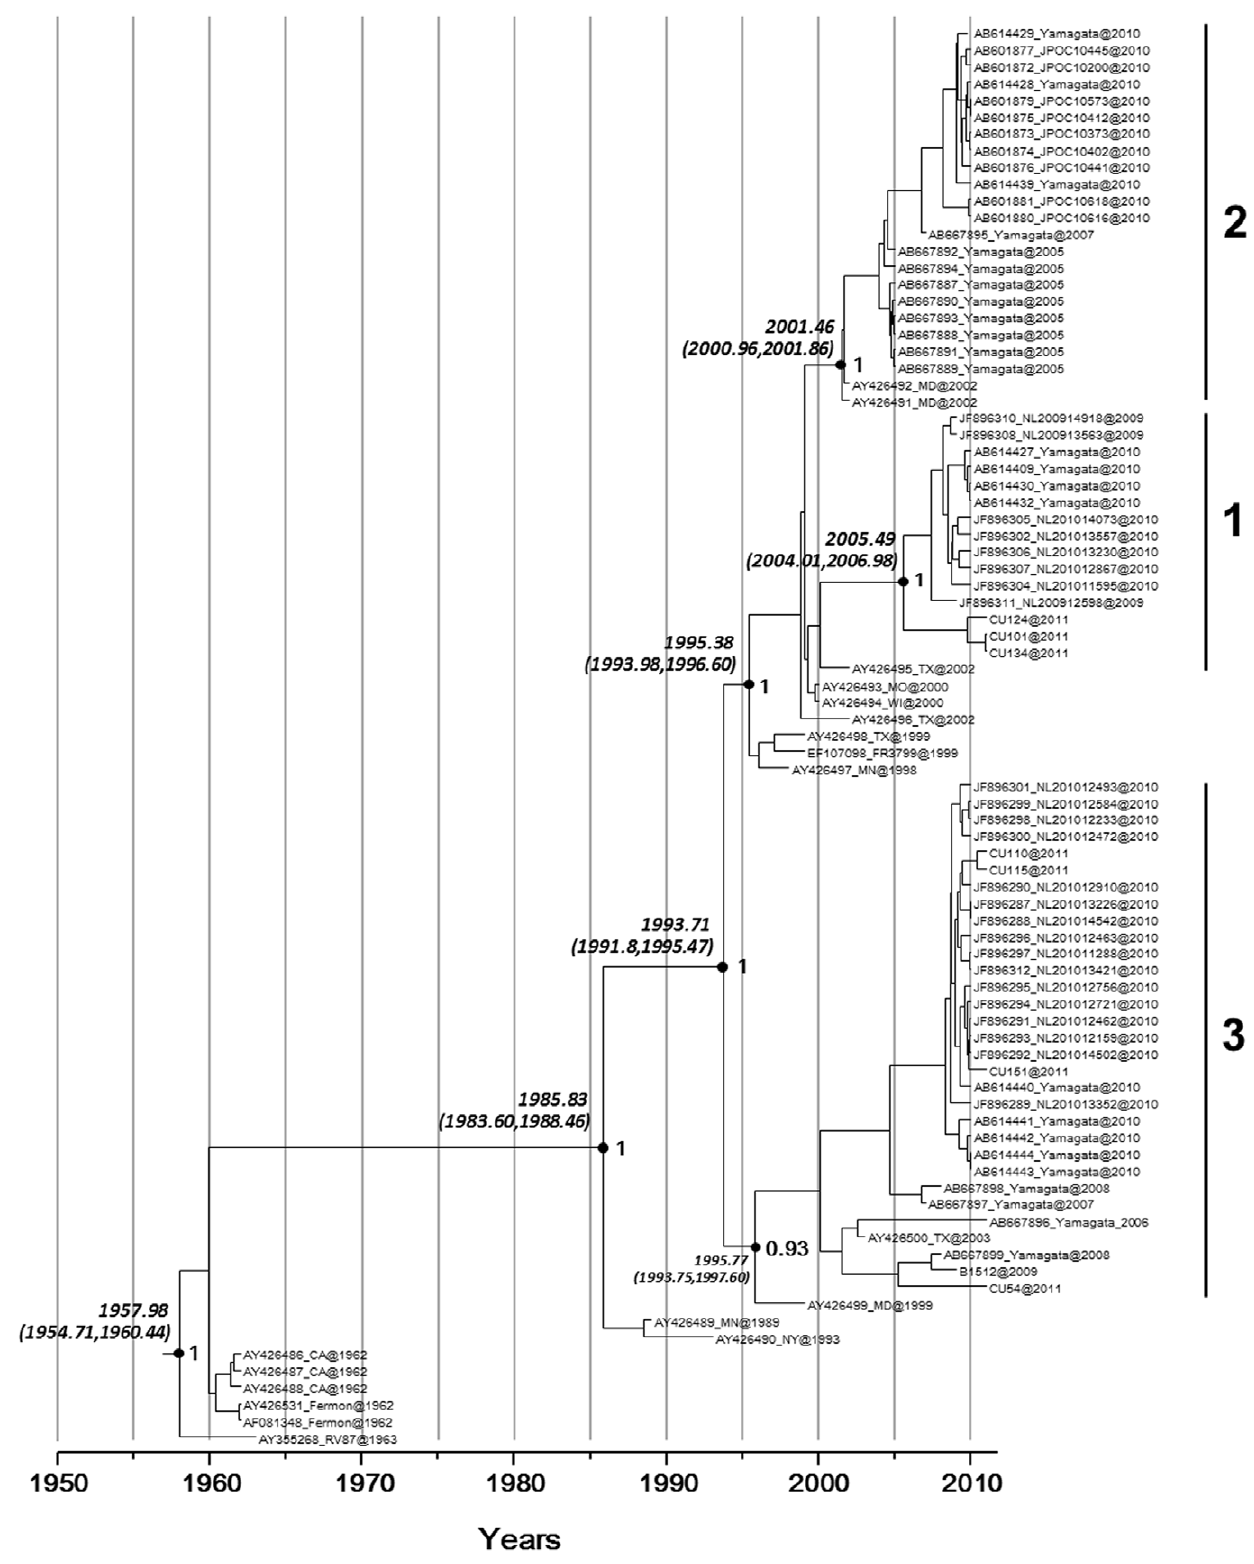
Figure 4. A maximum clade credibility tree from Bayesian timescale phylogenetic analysis of EV68 (dataset 2; n=106 sequences, length=723 nt). The posterior probabilities and 95% HPD intervals of the key nodes are depicted above the respective nodes. Three major recent clusters are marked by vertical lines.